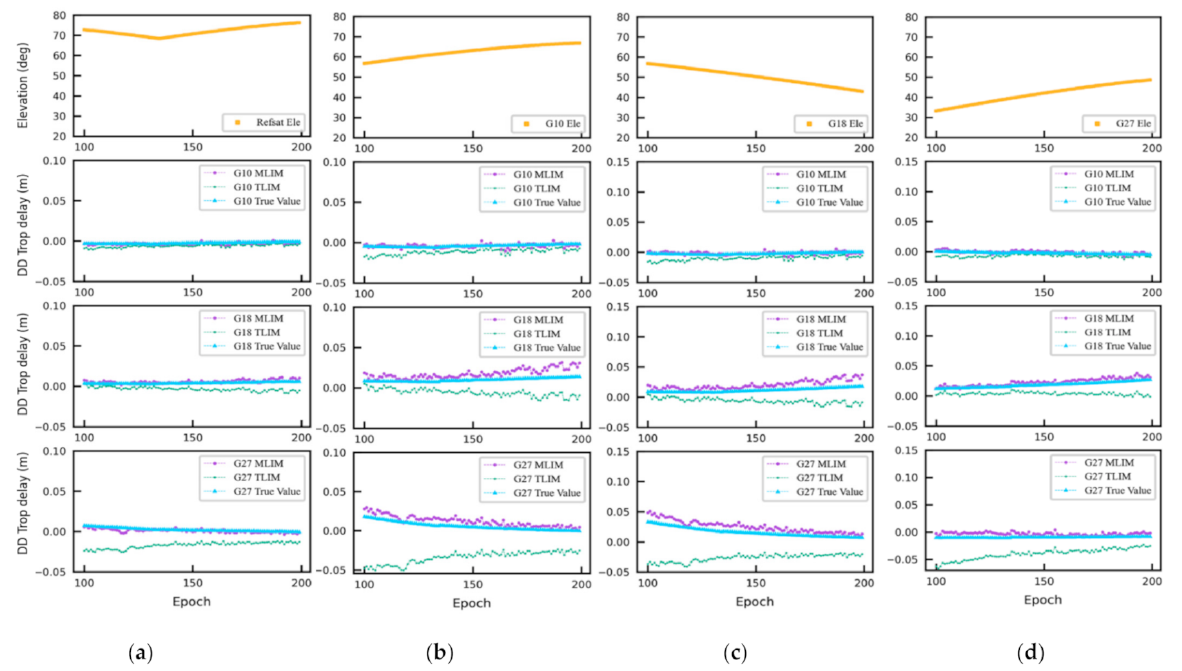
Figure 13. Elevation angles (upper row) for the reference satellites G10, G18, and G27. The DD tropospheric delay obtained using the TLIM and the PPP method (three lower rows) at different rover stations: ( a ) P532, ( b ) P539, ( c ) P602, and ( d )